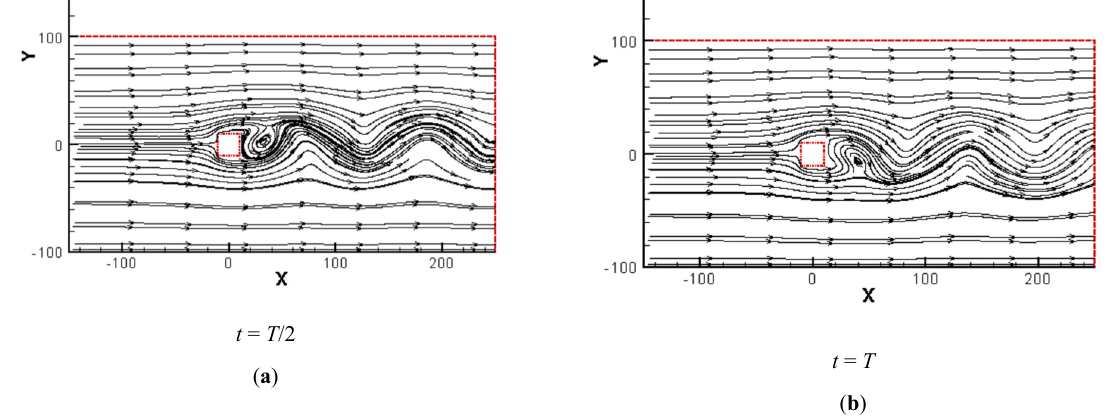
Figure 8. Streamlines of von Karmann vortex street at t = ( a ) T /2 and ( b ) T . (unit: m).